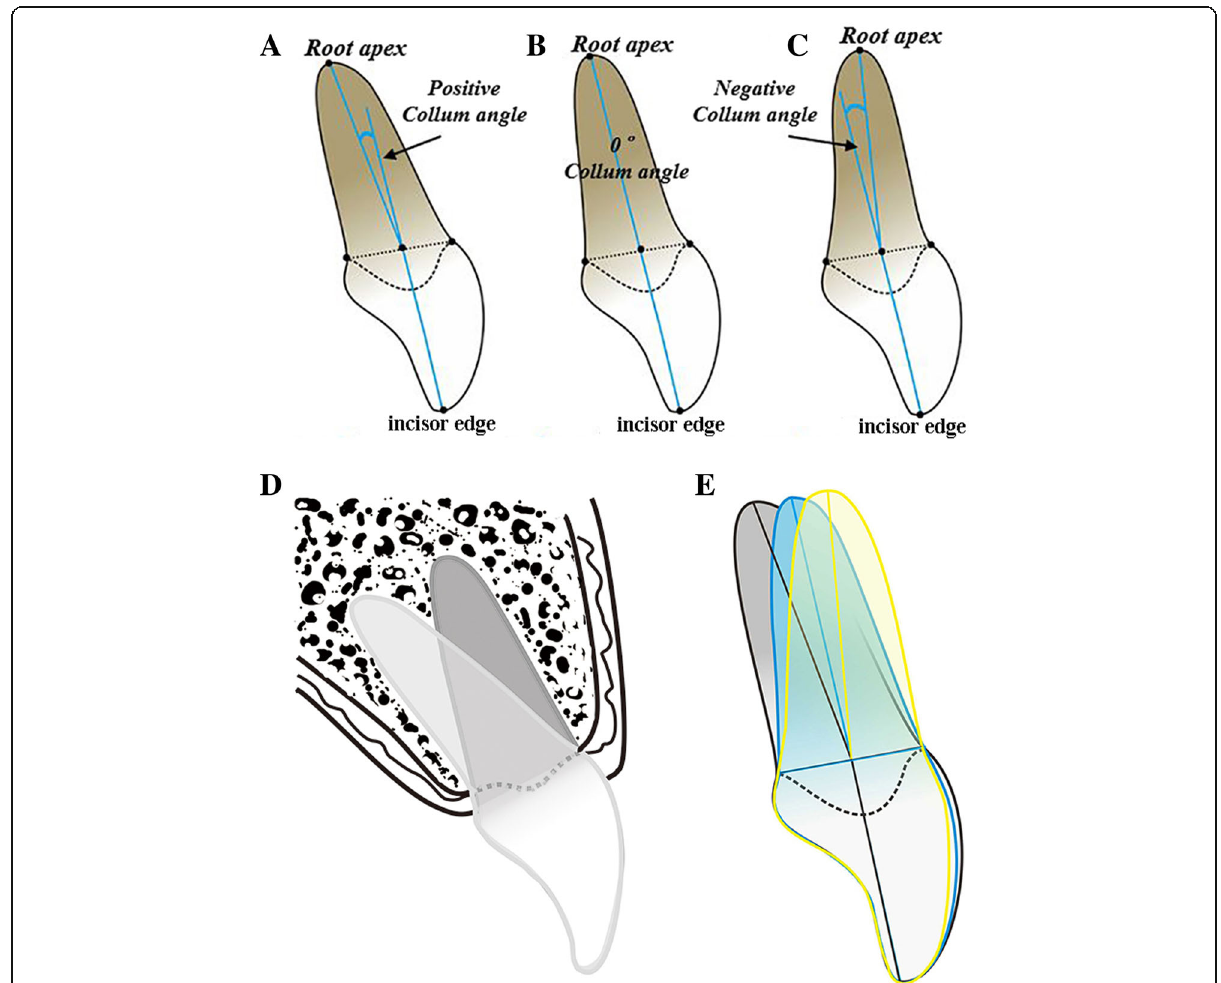
Fig. 7 The various Collum angle in central incisor, the long axis of the root can deviate to the labial side ( a ) or lingual side ( c ) of the long axis of the crown, or coincidence ( b ). The schematic diagram indicates that the root bends toward lingual cortical alveolar because of Collum angle ( d ). The schematic diagram elucidates that the more obvious Collum angle accompanies with the greater labial surface curvature of the crown ( e